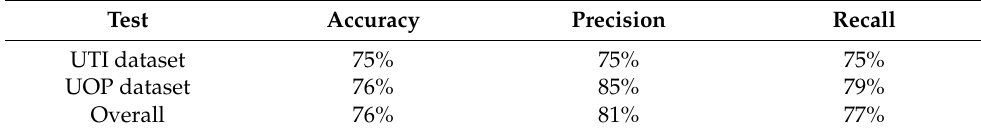
Table 4. Full system performance.